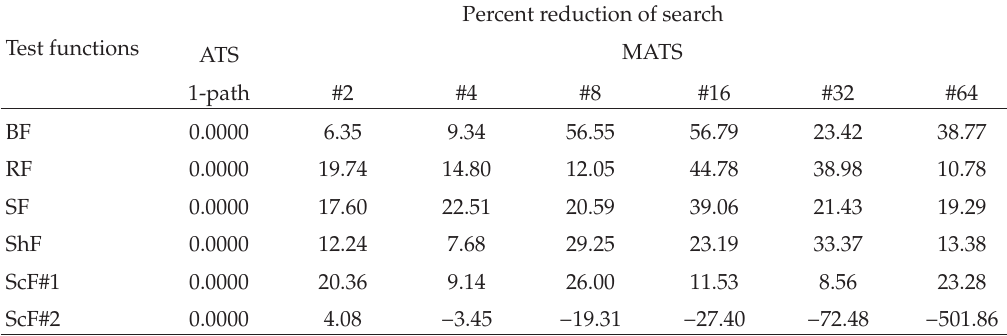
Table 9: Percent reduction of search